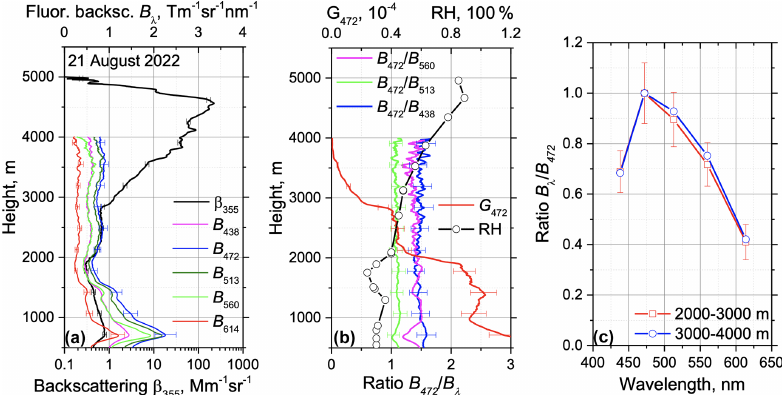
Figure 9. Vertical profiles of the particle parameters on 21 August 2022 for the period 22:00–24:00UTC. (a) The fluorescence-spectral- backscattering coefficients B λ at 438, 472, 513, 560 and 614nm and the aerosol-backscattering coefficient β 355 . (b) The ratios B 472 /B 438 , B 472 /B 513 and B 472 /B 560 and the fluorescence capacity G 472 . Symbols show the relative humidity measured by a radiosonde at 00:00UTC on 22 August. (c) Spectrum of the fluorescence-backscattering coefficient B λ for height intervals of 2000–3000 and 3000–4000m. Values of B λ are normalized according to B 472 .